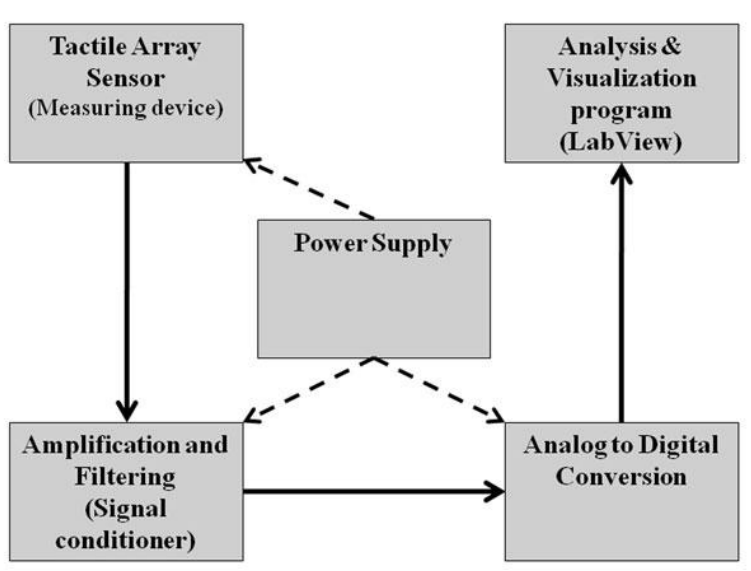
FIGURE 1. Block diagram of the proposed electronic system. Data flow is represented with solid arrows between units and power supply with dashed